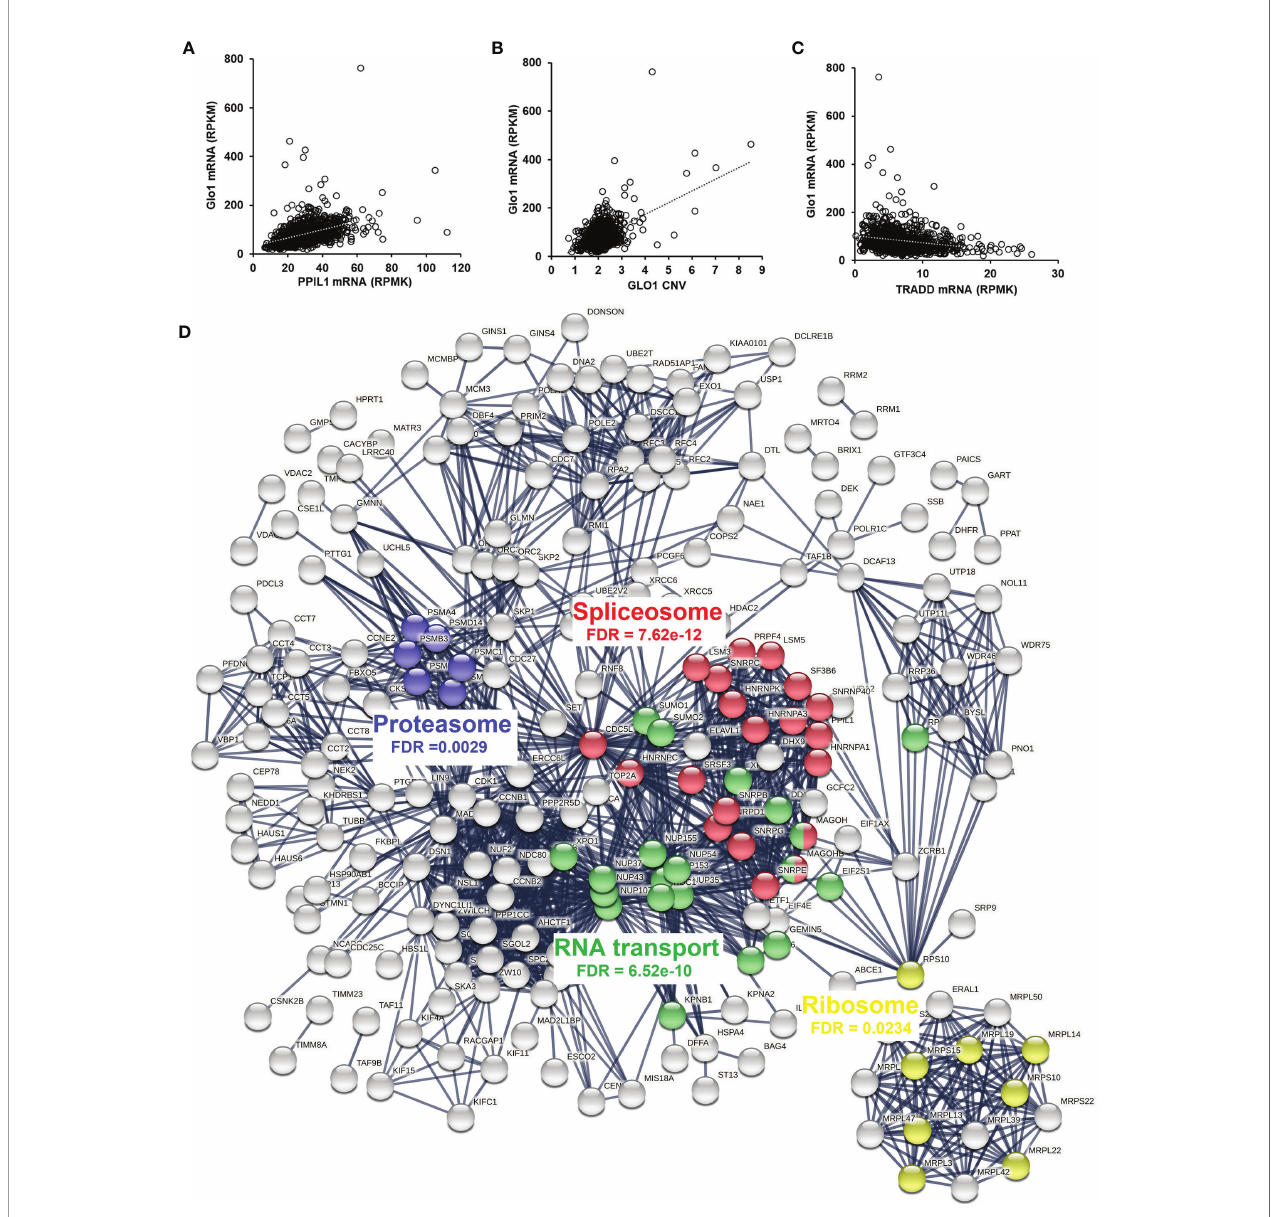
FIGURE 4 | Correlation of glyoxalase 1 expression in human tumor cell lines and clinical human breast cancer with chemotherapy treatment — a negative survival factor. (A – C) Correlation of Glo1 expression in the CCLE human tumor cell line database. (A) Correlation of Glo1 with PPIL1 ( r = 0.57). (B) Correlation of Glo1 with GLO1 CNV ( r = 0.53). (C) Correlation of Glo1 with TRADD ( r = − 0.35). (D) Protein interaction network among genes with expression highly correlated positively with GLO1 in the CCLE human tumor cell database. Several enriched KEGG pathways are highlighted and their signi fi cance indicated (false discovery rate (FDR)). For clarity, only the largest connected component is